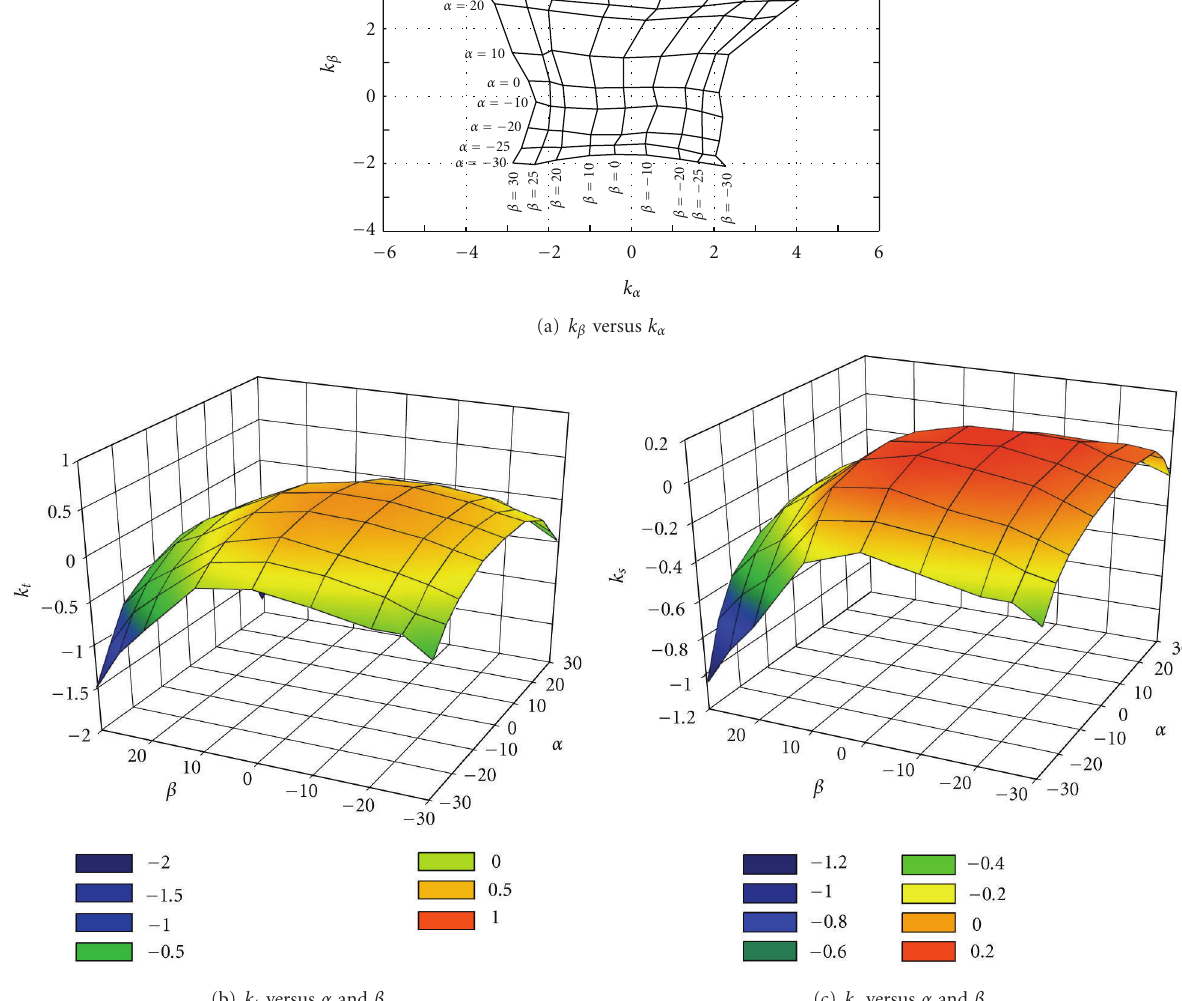
Figure 2: Five-hole probe calibration